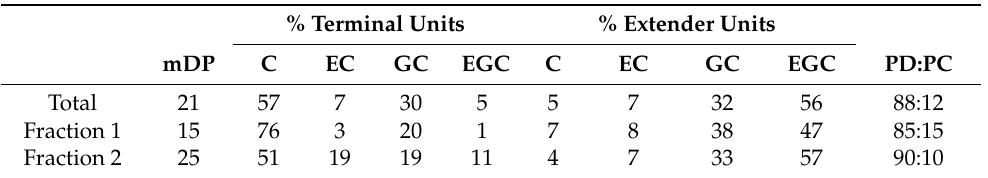
Table 3. Thiolysis reaction products of total tannins and tannin fractions from H. coronarium as % contributors of terminal and extender flavan-3-ol